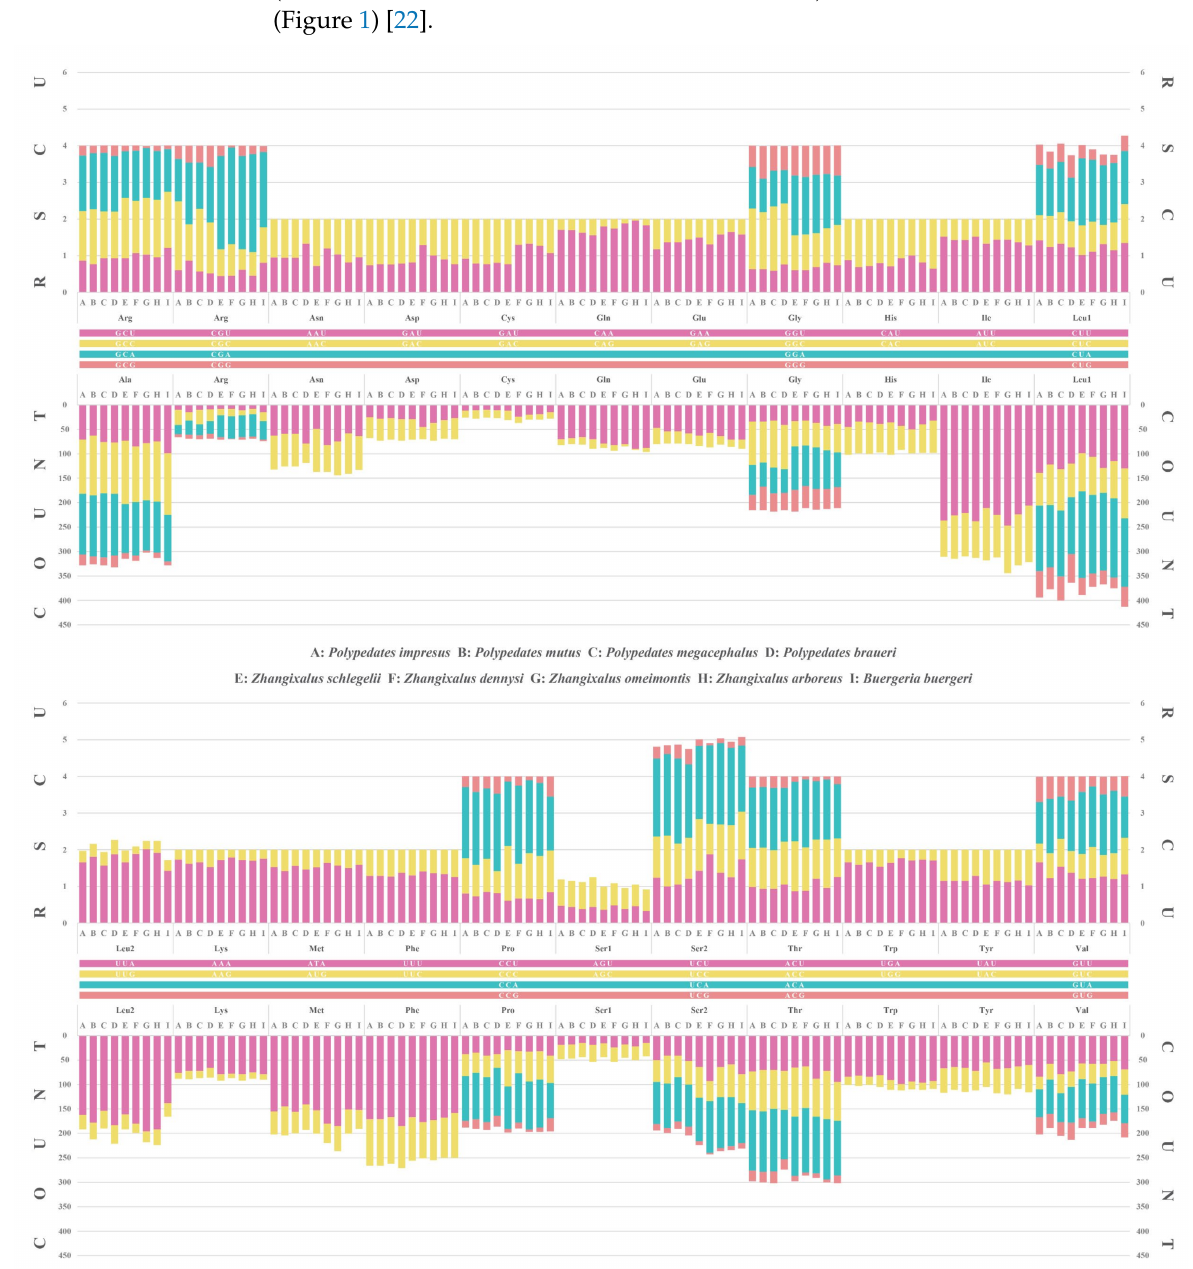
Figure 2. Amino acid and codon usage in the protein-coding genes (PCGs) of nine rhacophorid mitogenomes. The X -axis represents 22 codon families. The Y -axis on the upper X -axis represents the relative synonymous codon usage (RSCU), while the lower represents the number of different codons employed for each amino acid. Detailed numerical information can be accessed in Table